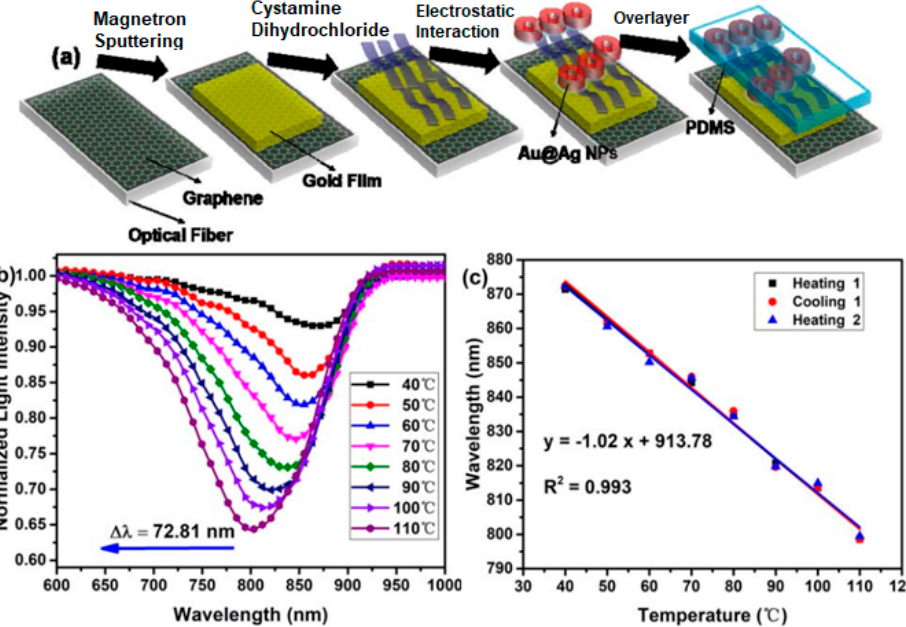
Figure 15. ( a ) SPR probe fabrication process. ( b ) SPR transmittance spectrum at different temperatures from 40 °C to 110 °C. ( c ) SPR response and fitting curve after heating and cooling process (adapted with permission from Reference [61], copyright IEEE).